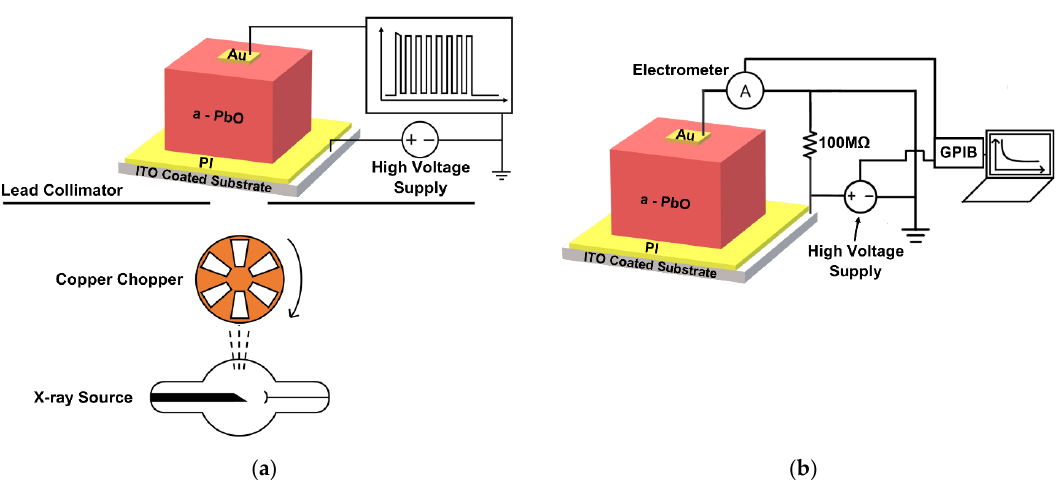
Figure 2. Experimental setups for ( a ) modulated and continuous XPM and ( b ) DC